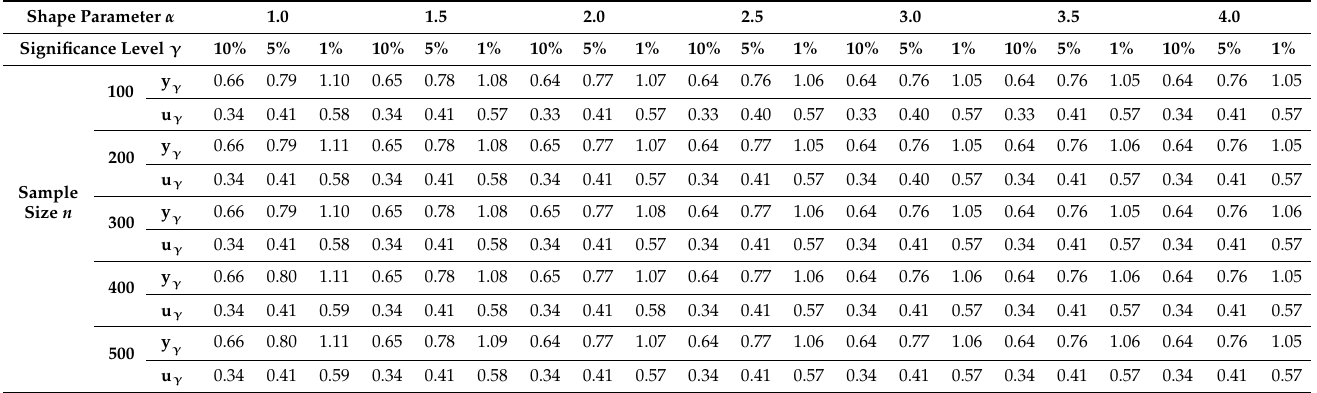
Table A1. Critical values y γ and u γ for various shape parameters α and sample sizes n